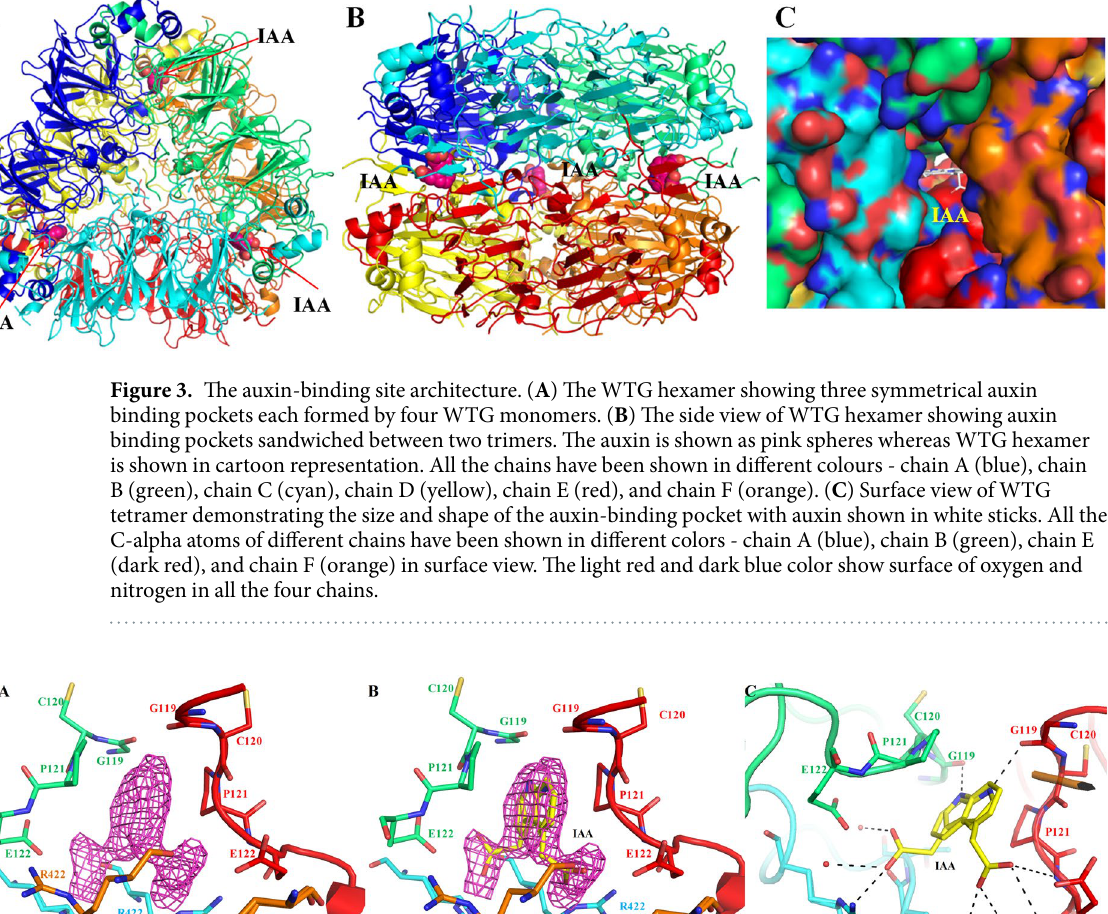
through two of its important functional moieties, the indole ring, and the carboxyl side chain. The indole ring goes deep in the pocket and makes pi-sigma interaction with Pro121 of two chains lying diagonally opposite to each other. The two orientations of auxin shares similar interactions because the residues involved from chain B and C are symmetrically related to the corresponding residues from chain E and F, respectively (Fig. 4C). In one orientation, the amine group of the indole ring bonds with the backbone oxygen atom of Gly119 of chain E. The carboxyl side chain oxygen atom of auxin interacts with side chain NH 2 and NE atoms of Arg427 of chain C and water molecules in the nearby vicinity. Another carboxyl side-chain atom of auxin interacts with side chain OE1 atom of Glu122 of chain E and the backbone oxygen atom of Arg422 of chain C. In the second orientation, the amine group of the indole ring bonds with the backbone oxygen atom of Gly119 of chain B. The carboxyl side-chain atom of auxin interacts with the NH backbone and OE1 side chain atoms of Glu122 of chain A. The other carboxyl side-chain atom of auxin interacts with side chain OE1 atom of Glu122 of chain A and the backbone oxygen atom of Arg422 of chain D. In the cavity formed at the interface of other chains of the hexamer, the carboxyl side-chain atom of auxin sometimes shifts more towards chain E and interacts with a side-chain OE2 atom of Glu122 and the backbone oxygen atom of Ser424 through water bridges. The direct and indirect (through water bridges) hydrogen-bonding networks conferred by four chains pre- cisely balance the alternate orientation of auxin. The interaction pattern was found to be same in all the symmet- rical pockets. Along with auxin, there was a clear density for a PEG ion. PEG interacts with auxin and stabilizes it inside the hydrophobic cavity.